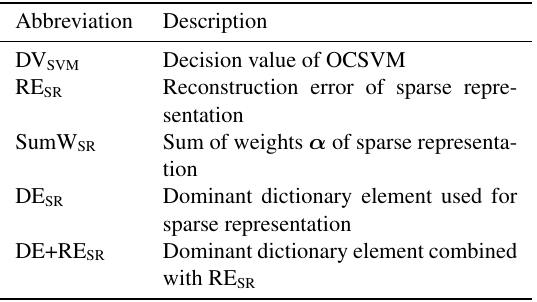
Table 1: Abbreviations for the outcomes of the used disease de- tection